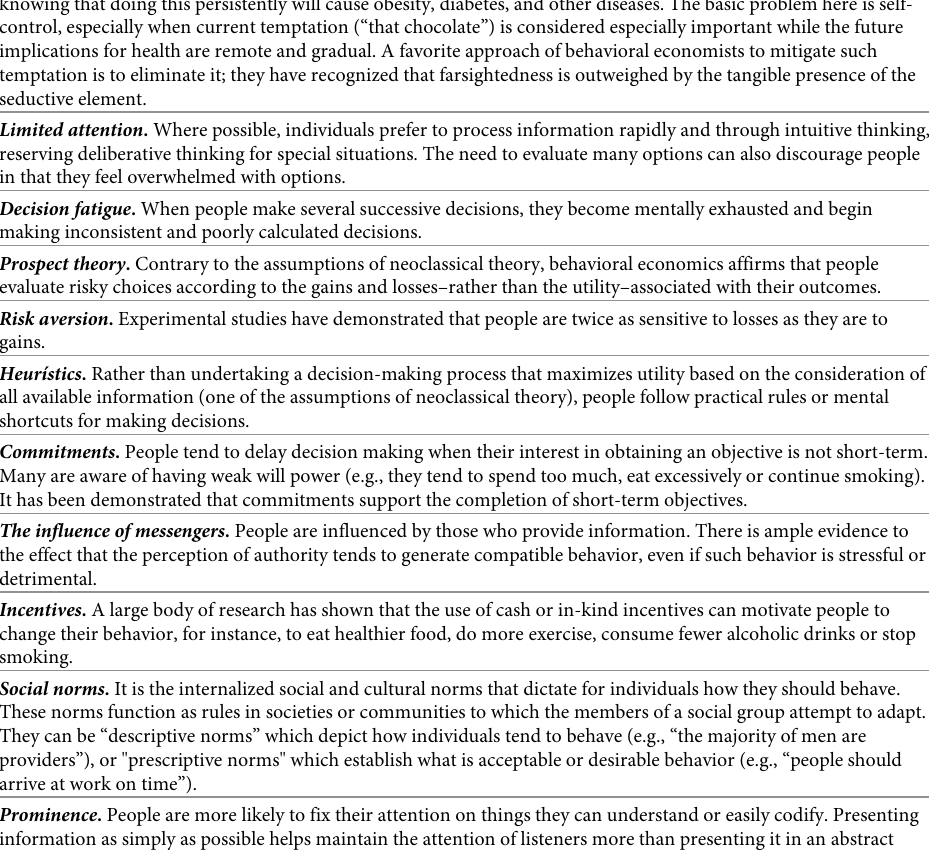
Table 1. Cognitive biases that influence participation in social programs [3, 21, 22, 45, 59]. Present bias . It is natural for people to value the present moment more than the future. This preference, known as temporal discounting, is illustrated by the fact that people obtain pleasure from eating fatty and sweet foods knowing that doing this persistently will cause obesity, diabetes, and other diseases. The basic problem here is self- control, especially when current temptation (“that chocolate”) is considered especially important while the future implications for health are remote and gradual. A favorite approach of behavioral economists to mitigate such temptation is to eliminate it; they have recognized that farsightedness is outweighed by the tangible presence of the seductive